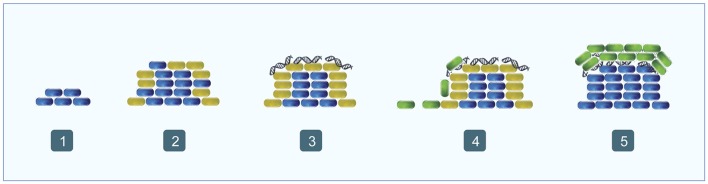
Biofilm formation in Pseudomonas aeruginosa. (1) Non-motile cells begin to accumulate forming the stalk (blue); (2) most of the outer cells express the PQS system (orange); (3) eDNA begins to accumulate over the stalk forming ring-like shaped structures (orange fibers); (4) motile cells migrate toward the top the stalk (green); (5) motile cells form the cap (green).